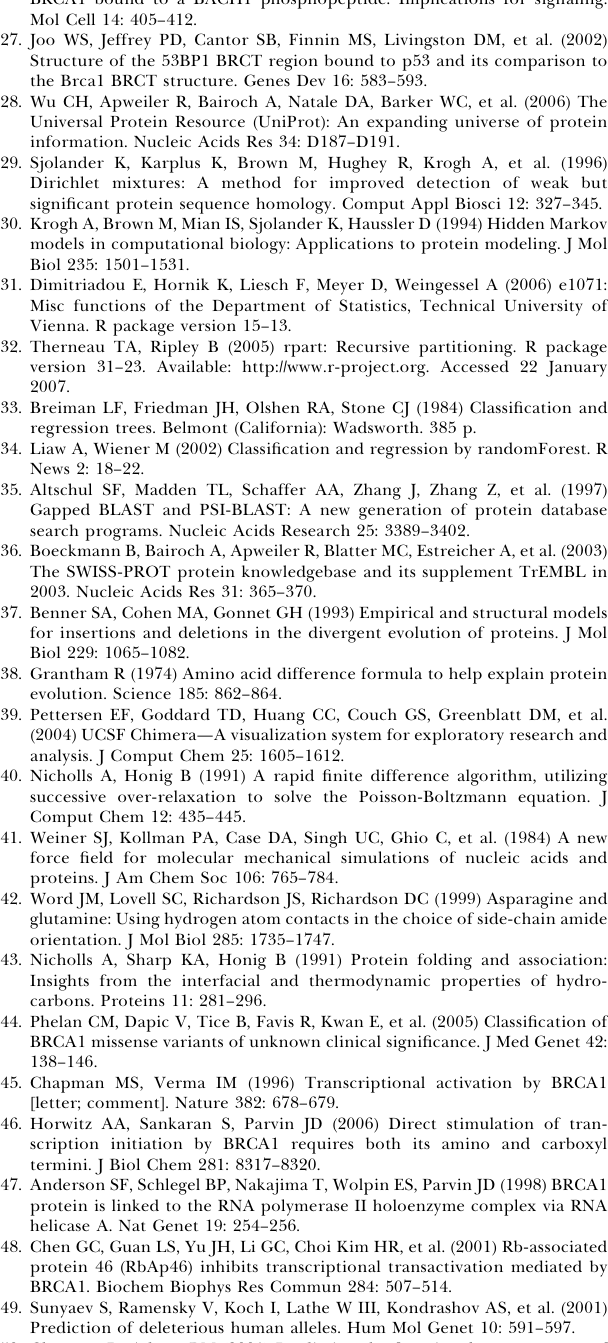
Table S5. Performance of Optimal 16 Features Evaluated with 10- Fold Cross-Validation Using the TP53 Missense Variant Training Set Performance was computed with all 16 features, then with each of the 16 features held out. MCC, Matthews correlation coefficient; TNR, true negative rate; TPR, true positive